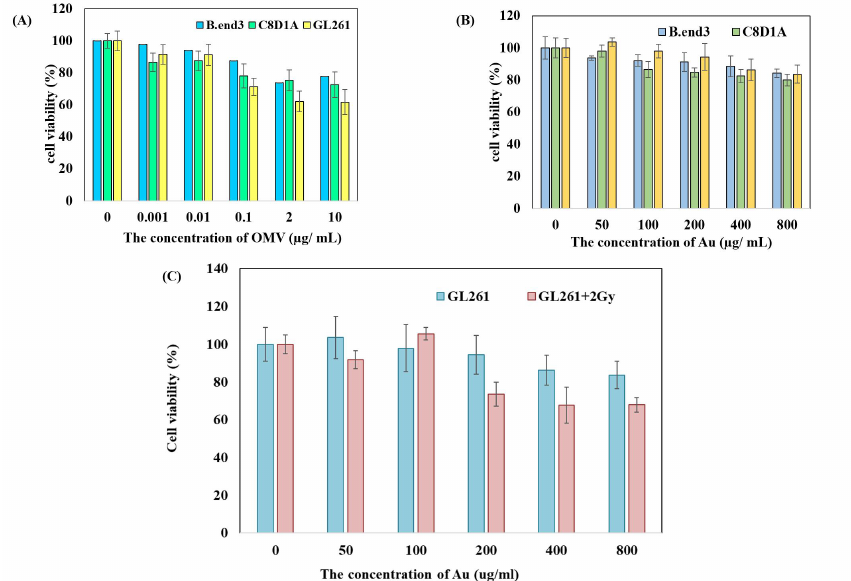
Figure 2. Toxicity of ( A ) OMV and ( B ) Au to B.end3 mouse brain endothelial cells, C8D1A mouse astrocytes, and GL261 mouse glioma cells. ( C ) Au augmented the radiotoxic effect towards GL261 mouse glioma cells.